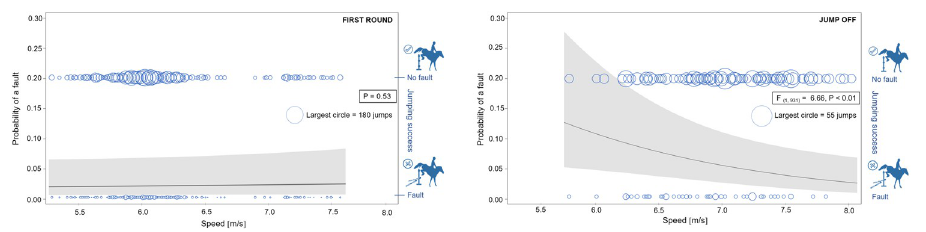
Fig 5. The probability of a fault in relation to the speed. The probability of a fault in relation to the speed in the first round (left) and jump off (right). The line and grey field show the predicted probability of a fault ± 95% confidence limit. Two rows of circles represent raw data of the numbers of faults (bottom row) or successful jumps (upper row). Circle size reflects the number of observations corresponding to the